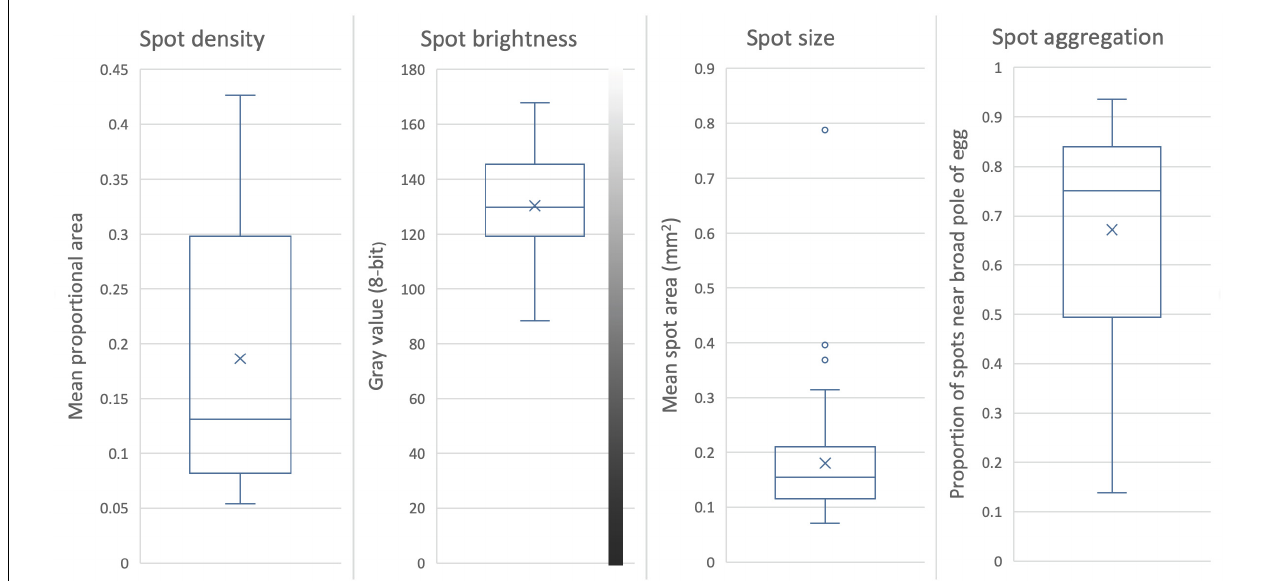
FIGURE 5 | Variation in maculation of Rüppell’s weaver eggs (66 eggs in 29 clutches). Box and whiskers divide the data into quartiles, with the median value indicated by the midline, the mean by an X, and outliers by circles. Maculation on the eggs of this species consists of at least two layers of spots; values here are for all layers combined. Spot density is the mean proportional area of the eggshell covered with spots. Spot size is the mean area of an individual spot. Spot brightness is the mean gray value in 8-bit grayscale, range 0–255. Spot aggregation is the degree to which spots are clustered near the broad pole of the egg (range 0–1), as indicated by 1 – the ratio of the area of spots at the narrow end to the area of spots at the broad